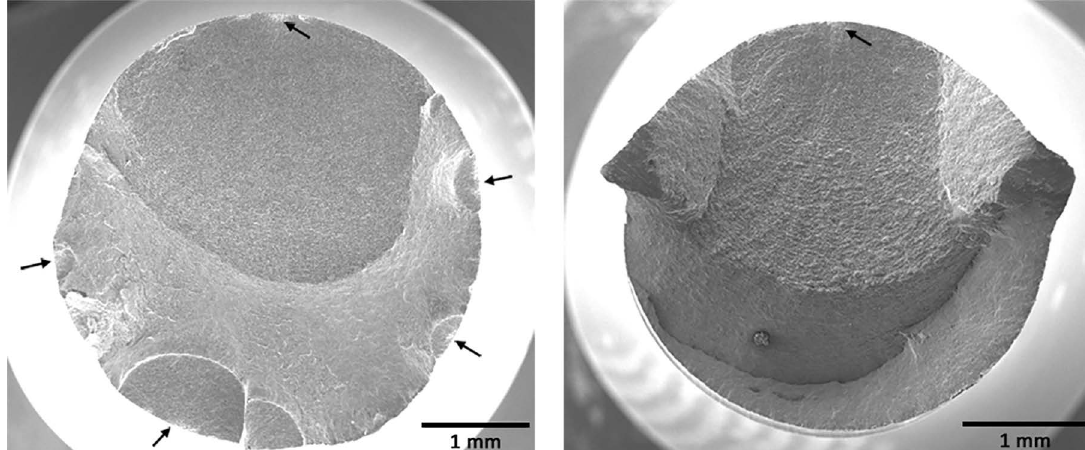
Figure 5. SEM micrographs of the fracture surface after fatigue tests: laser treated specimen in the left image and polished specimen in the right image. Each arrow indicates one crack nucleation